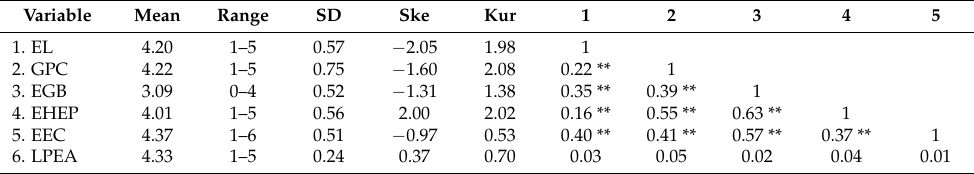
Table 2. Correlation matrix of the study